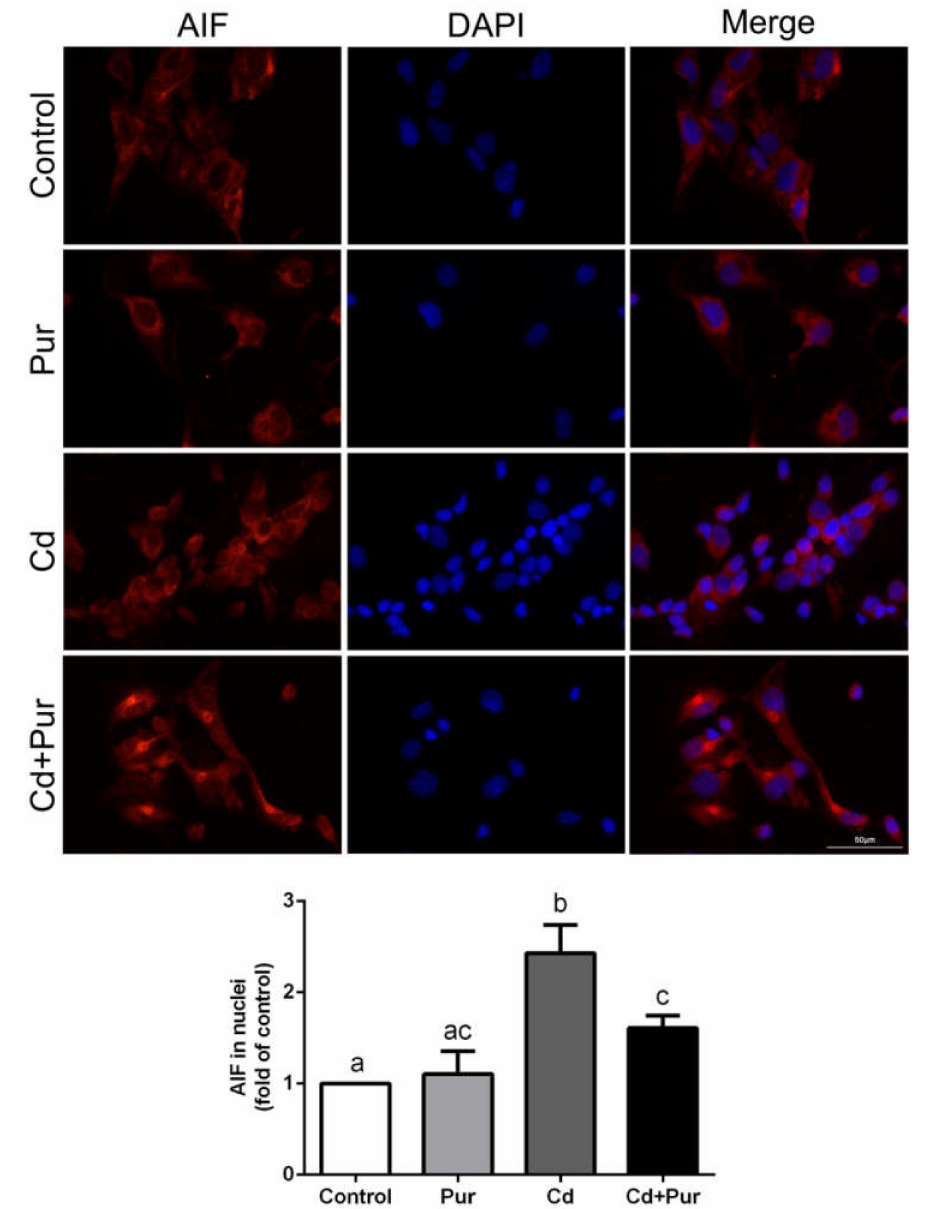
Figure 6. Pur prevents Cd-induced AIF nuclear translocation in the rat cerebral cortex in vivo. Rats were treated with Cd (50 mg/L) and/or Pur (200 mg/kg) for 90 days, after which the cerebral cortices were subjected to AIF immunofluorescence staining. Upper panel: representative immunofluores- cence staining images; lower panel: quantitative analysis (mean ± SD; n = 3). The means labeled without a common letter (a, b, c) are significantly different, p < 0.05. Scale. bar: 50 µ